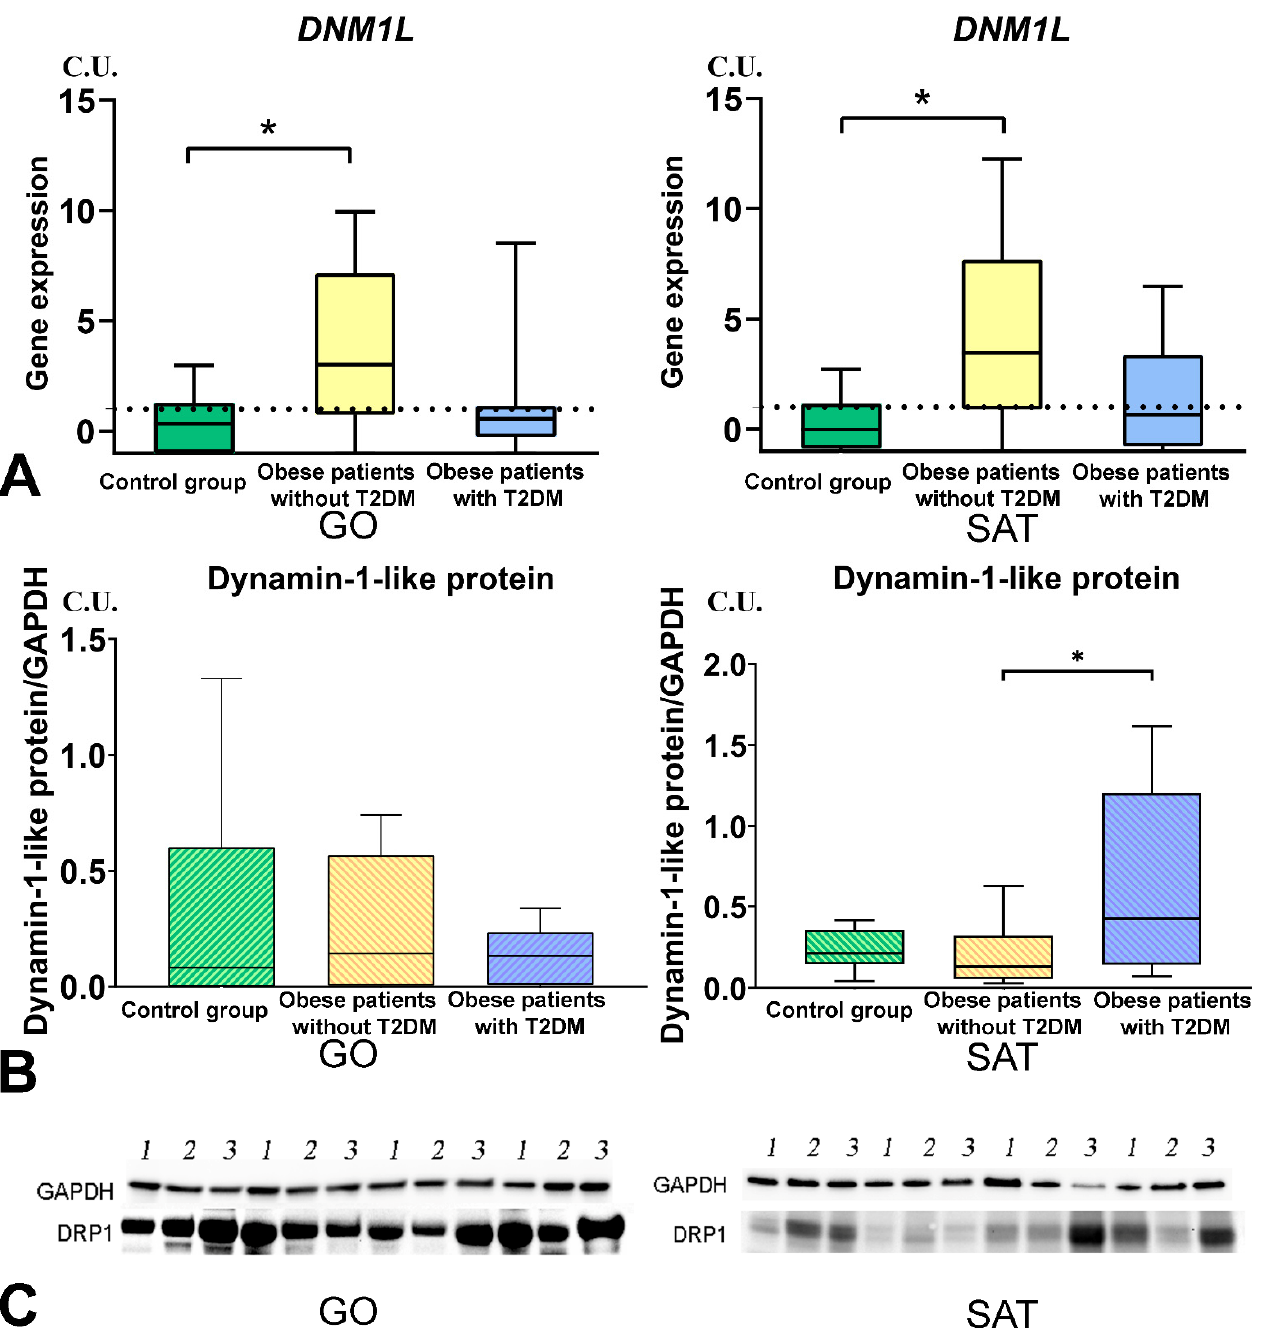
Figure 6. Study of tissue-specific production of DNM1L in obese patients with and without T2DM. ( A )— DNM1L genes expression in GO and SAT, n = 25; ( B )—Dynamin-1-like protein (DRP1) production in GO and SAT, Western blot analysis of AT biopsies, n = 8; ( C )—Protein DRP1 Western blot bands, n = 8. *— p < 0.05 significance is determined using the Mann–Whitney criterion for two independent samples.